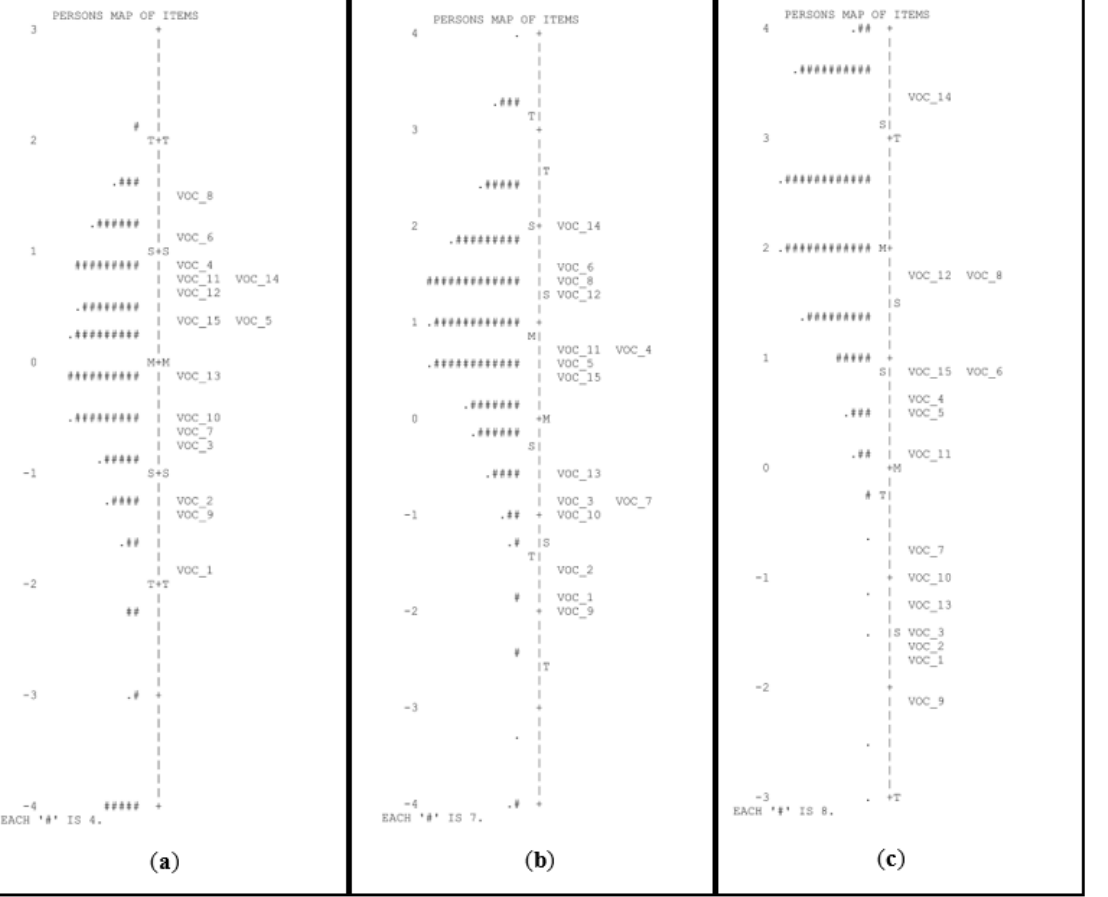
Figure 3. Person-item maps for the task of vocabulary in pre-K ( a ), kindergarten ( b ), and first grade of primary school ( c ) . # Refers to the number of persons.